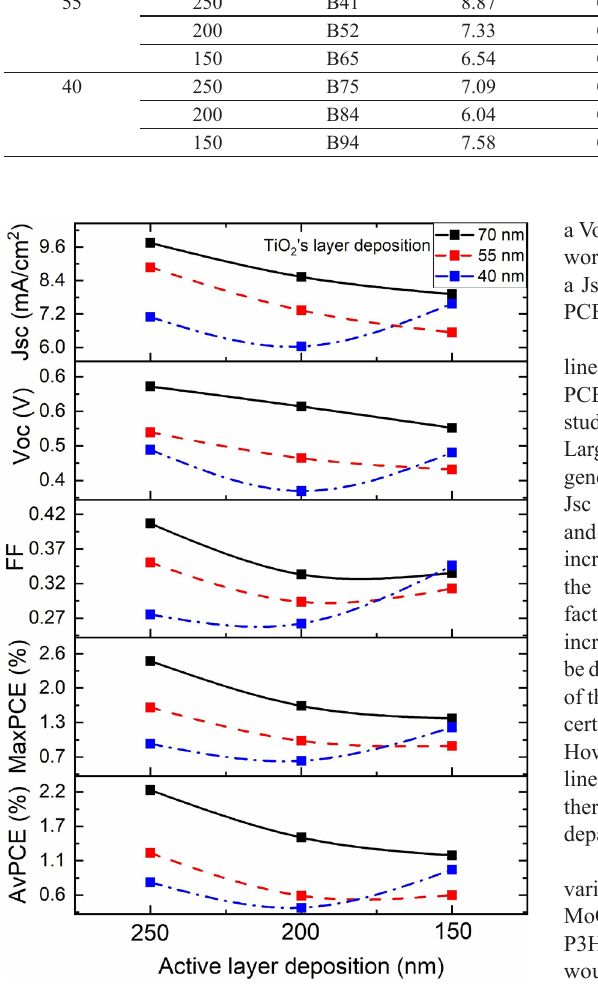
Table 2. Experiment A and the variation of their parameters in cells with the configuration FTO/TiO Time Sample